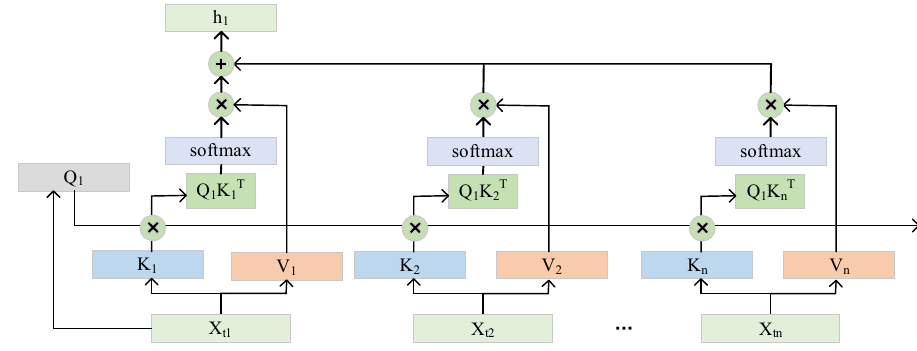
Fig. 3 Self-attention